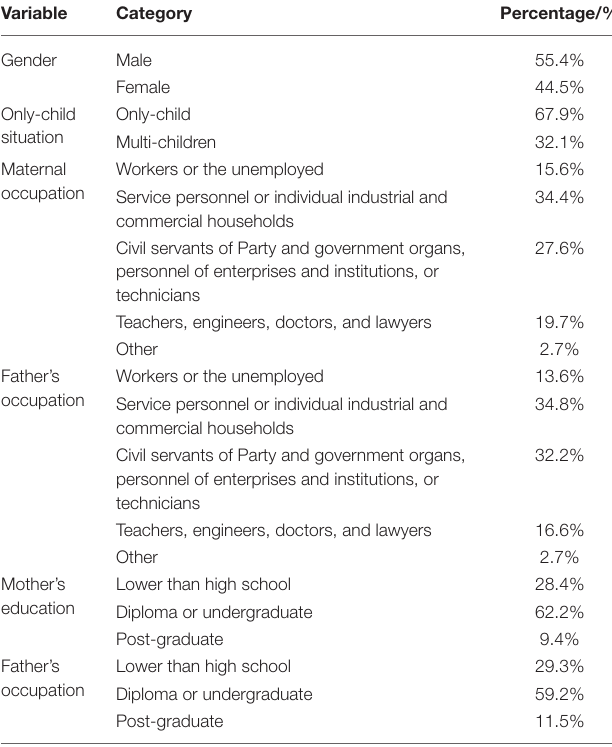
TABLE 1 | Statistics of sample FD.